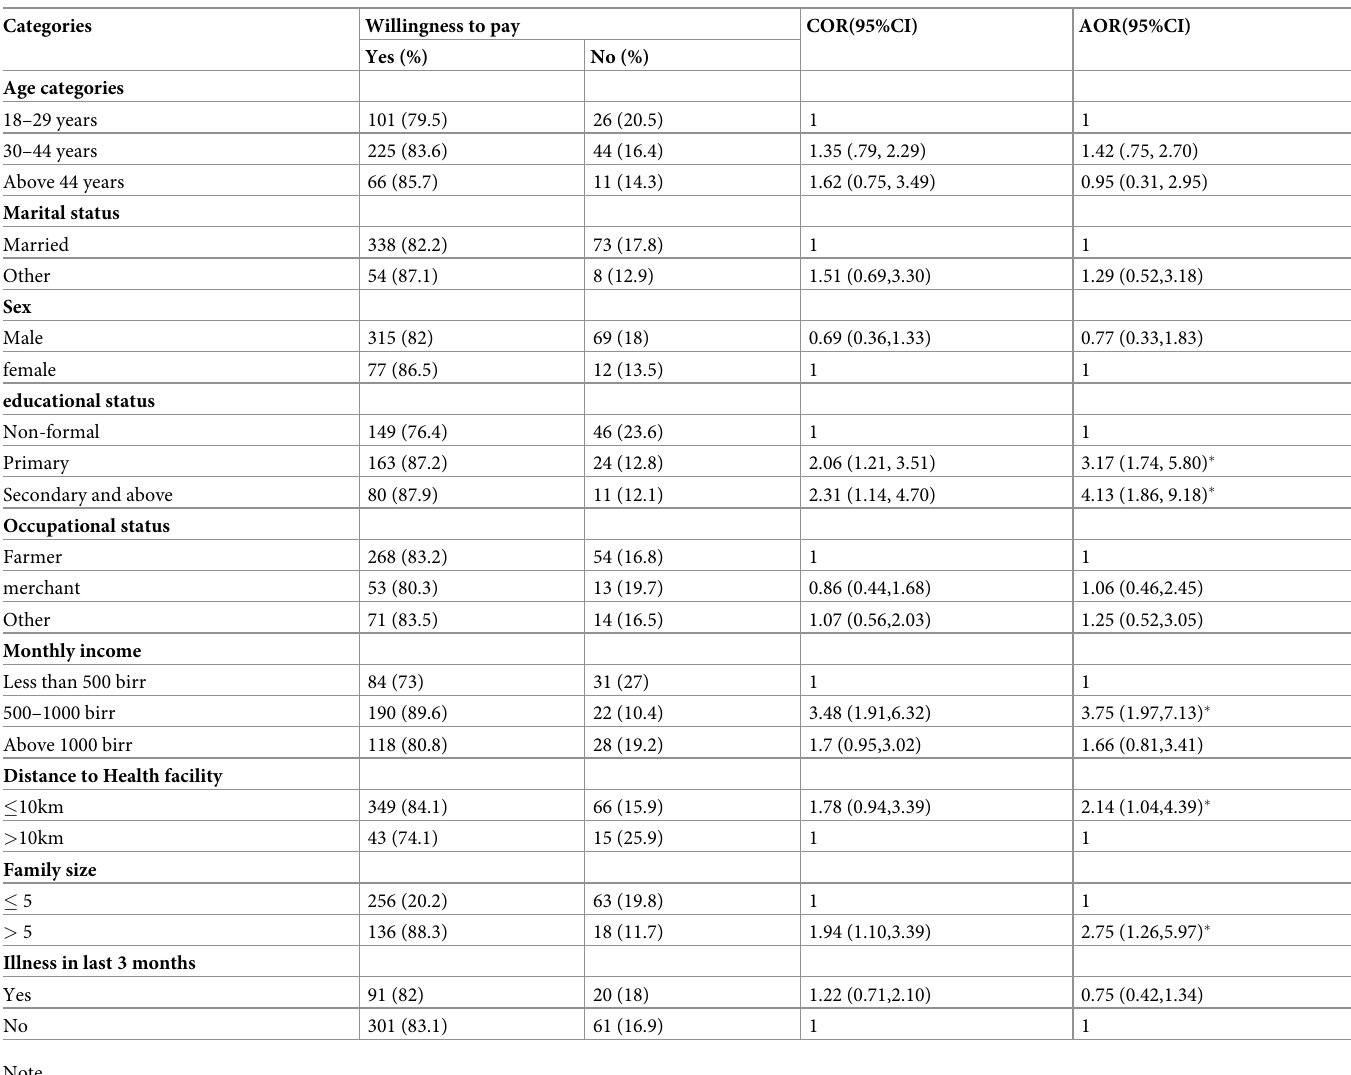
Table 5. Factors associated with respondents’ Willingness to pay for CBHI scheme,